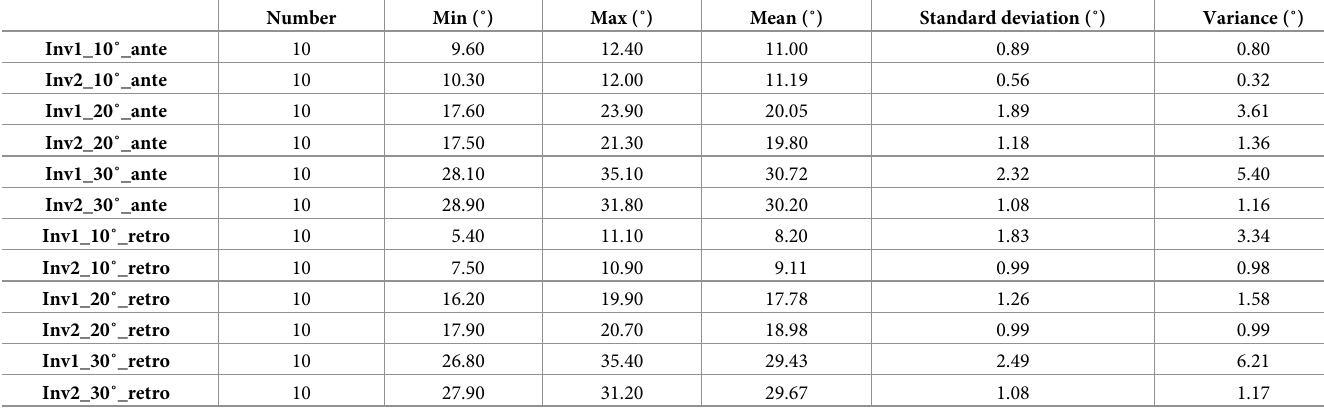
Table 1. Descriptive statistics showing minimum, maximum, mean, standard deviation and variance for each step of displacement.